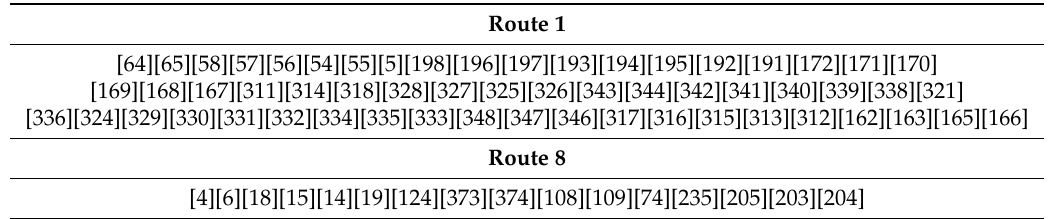
Table 9. The route order for retail stores delivered in Route 1 and 8 based on the ROPIRPSDRCO 2 .